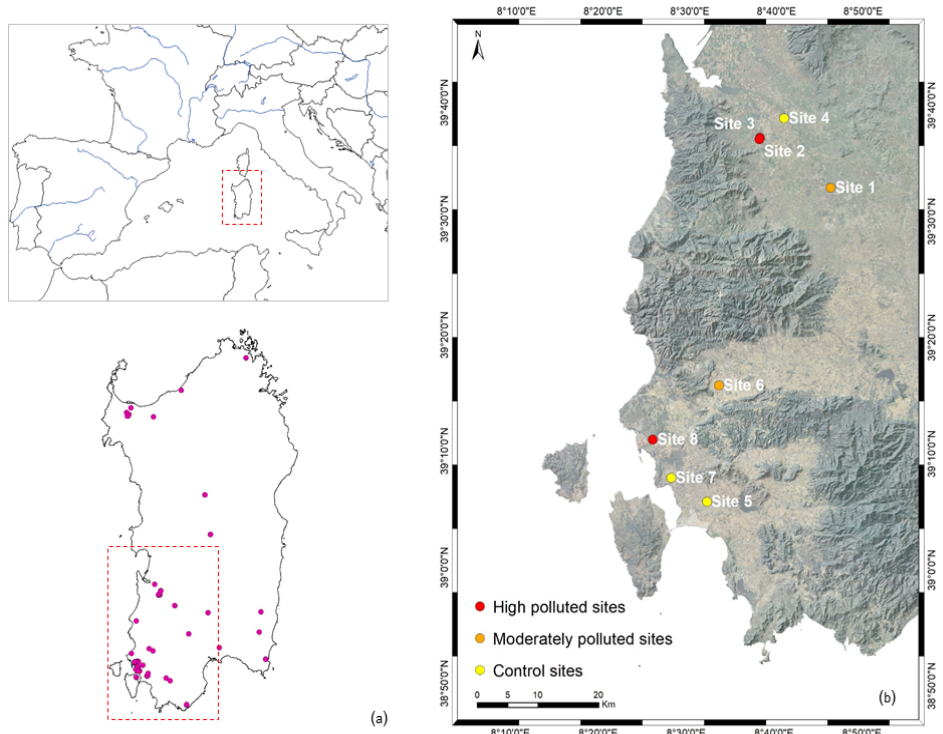
Figure 1. Case Study and selection of experimental fields: ( a ) polluted or mining georeferenced area, and request to participate by farmers in 2017 and 2018 (magenta symbol); ( b ) the Sulcis-Iglesiente study area and the five experimental fields, red ones are polluted sites, whereas yellow are control sites.